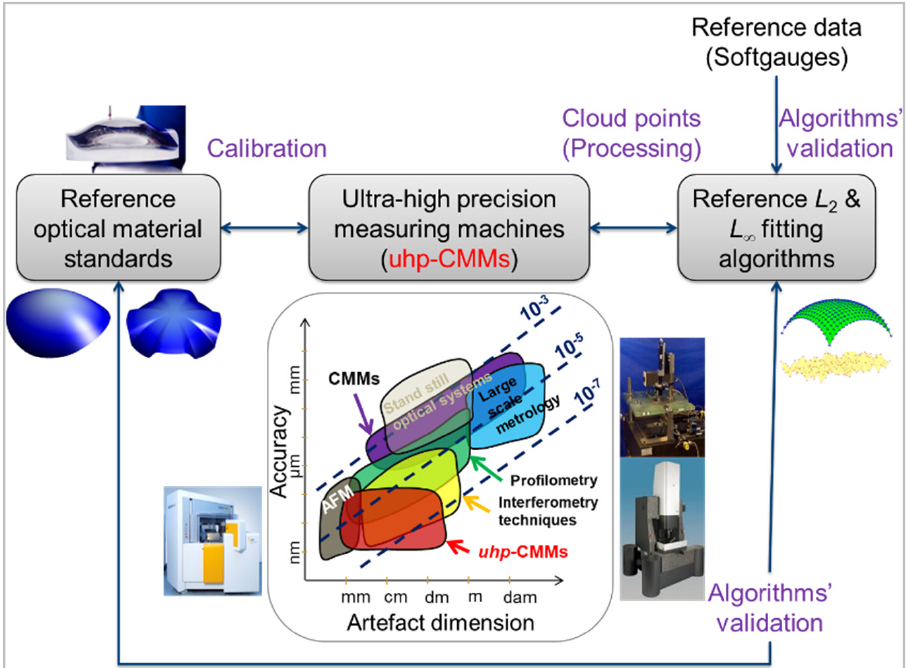
Figure 1. Description of the traceable reference full metrology chain for aspherical and freeform optical surfaces with respect to the SI unit meter definition. The traceable full metrology chain includes: high quality optical surfaces (1), ultra-high precision measurement machines (2) and robust reference algorithms (3) ensuring calculation error below the nanometer level.